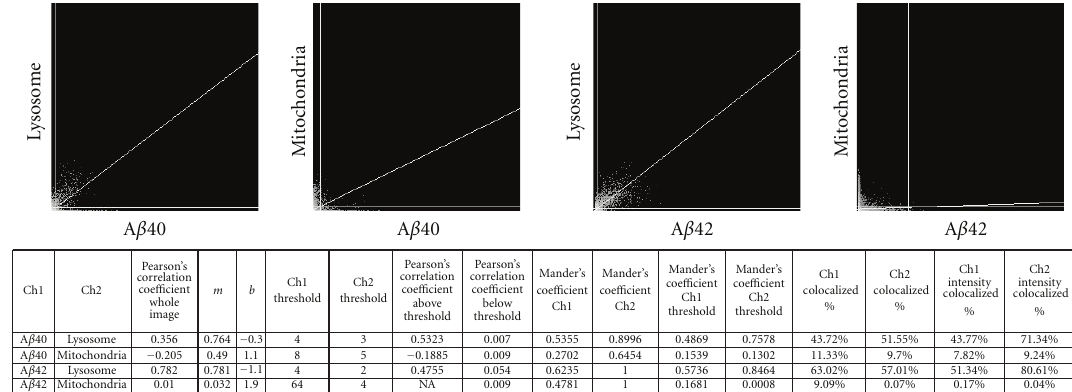
Figure 9: Quantitative colocalisation analysis of intracellular A β . Quantitative analysis indicates significant colocalisation of A β 40 24 and A β 42 24 with the lysosome marker within live